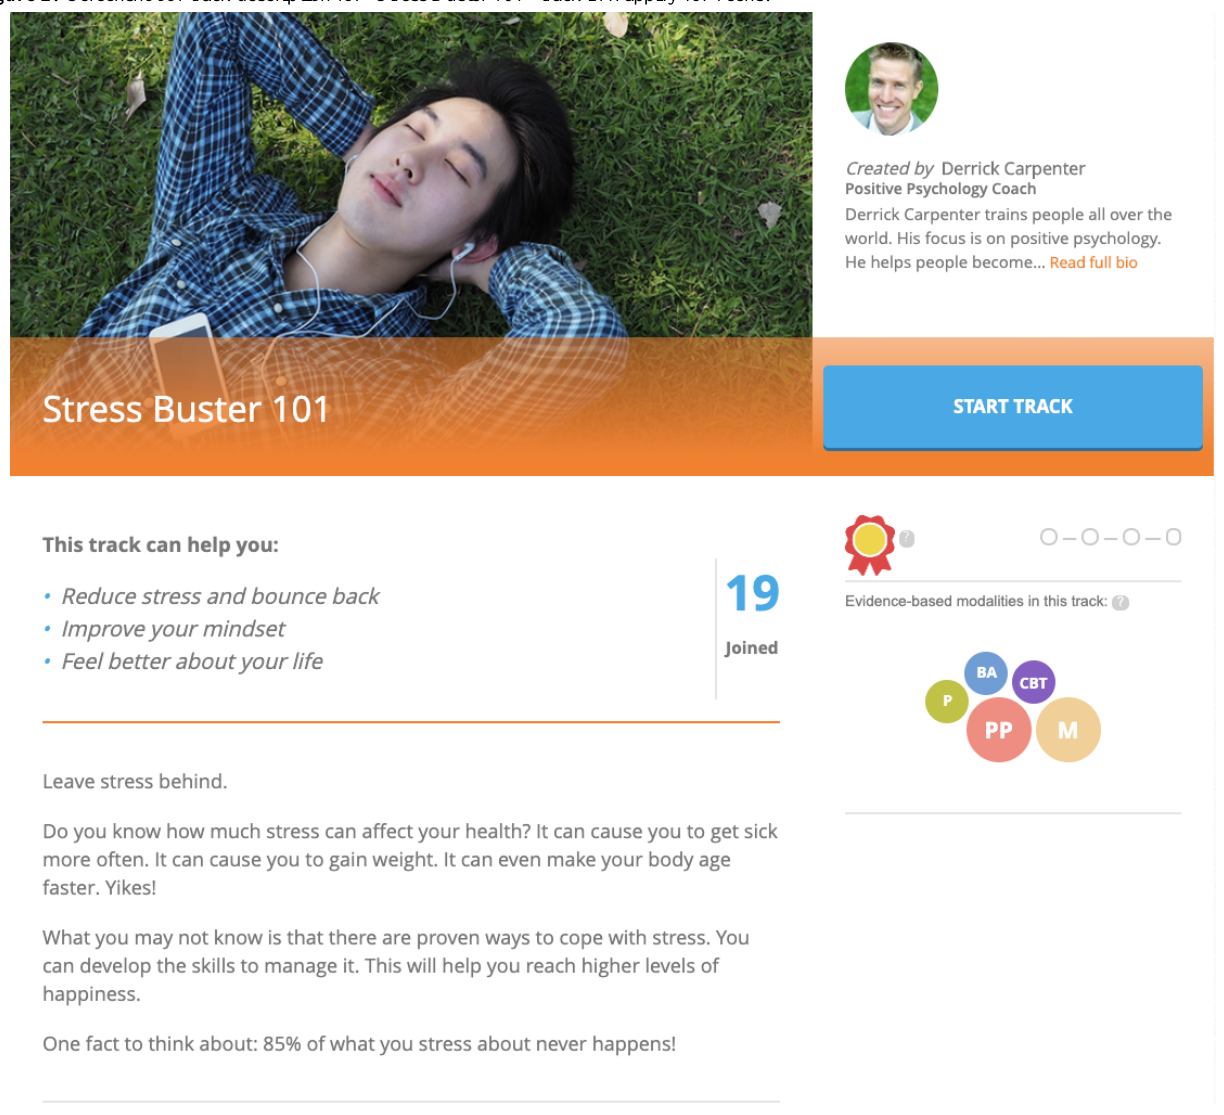
Figure 2. Screenshot of track description for “Stress Buster 101” track in Happify for Teens.